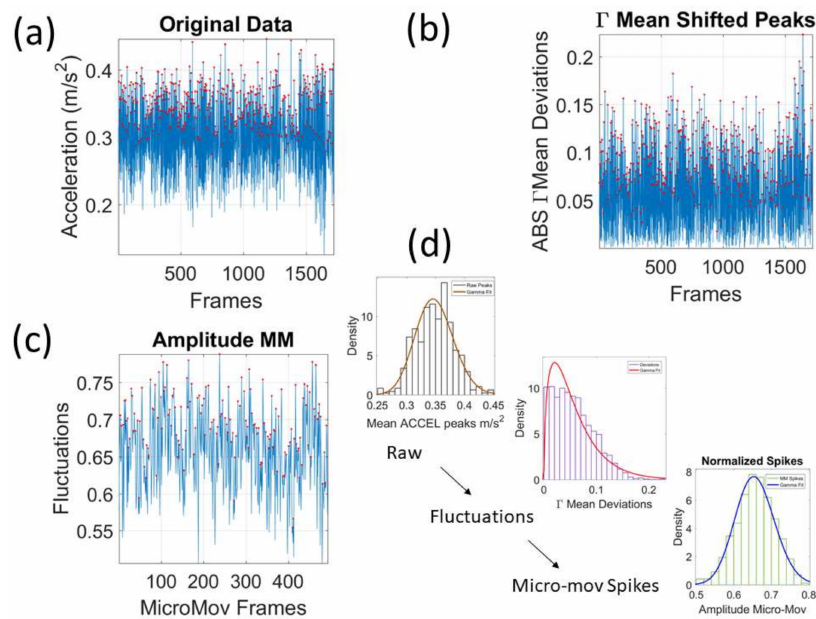
Figure 3. Pipeline of data analyses to construct the micro-movement spike trains. ( a ) Raw acceleration data with peaks marked by red dots (each peak is detected by a change in the slope from positive to negative trend). ( b ) Overall mean is empirically estimated and the absolute deviations are obtained and plotted for each frame. ( c ) The peaks are extracted and normalized using Equation (2). ( d ) Distributional analyses are performed to determine the best continuous family of distributions at each step fitting the frequency histograms of fluctuations in peak amplitude or peak